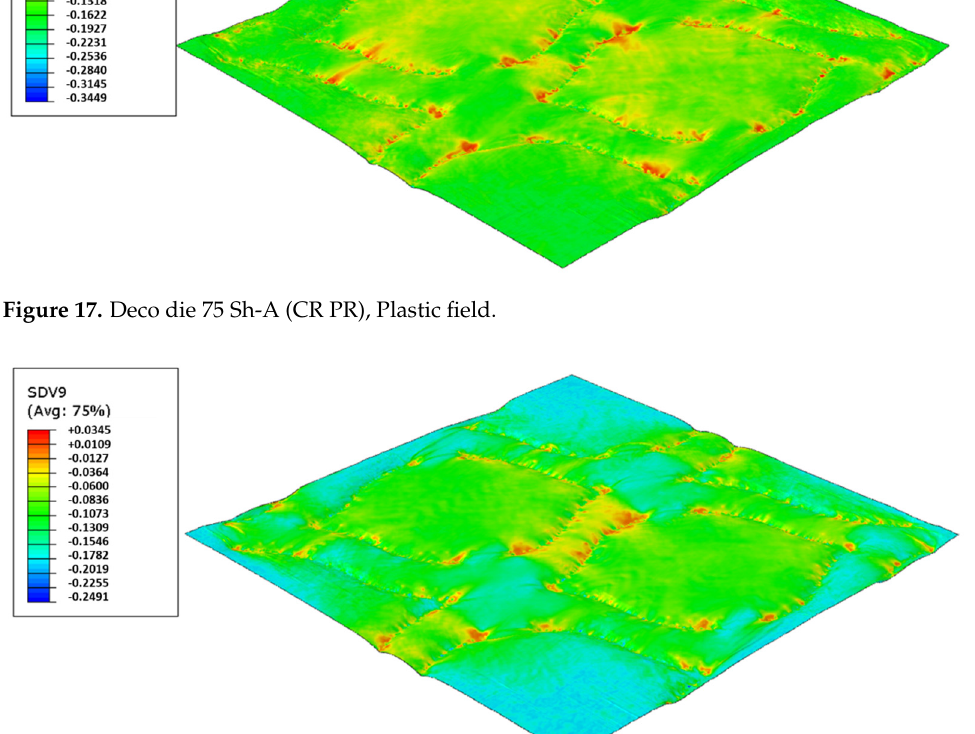
Figure 18. Deco die 60 Sh-A (SBR PR), Plastic field.